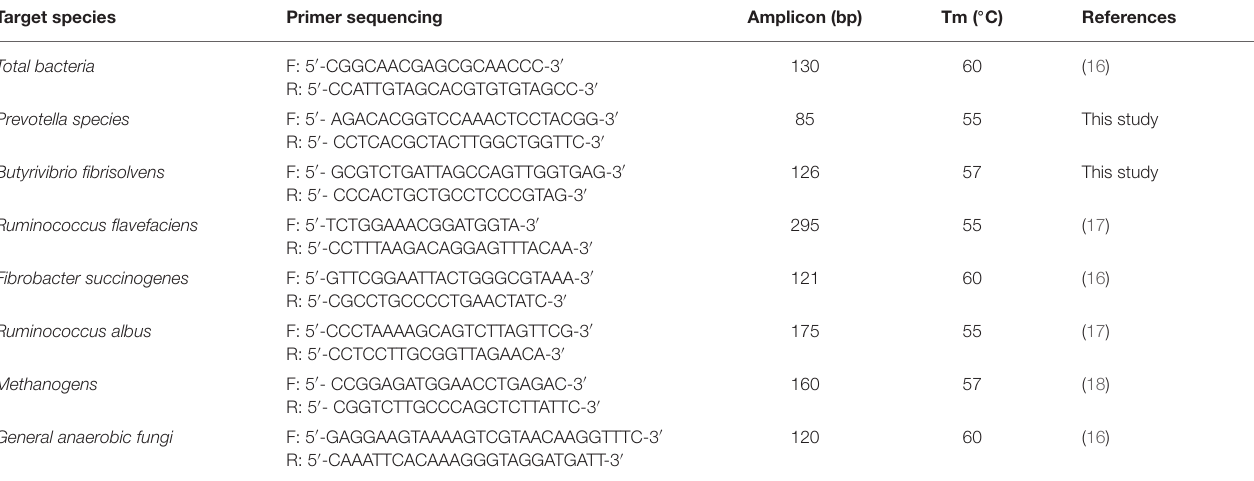
TABLE 1 | PCR primers for PCR and real-time PCR